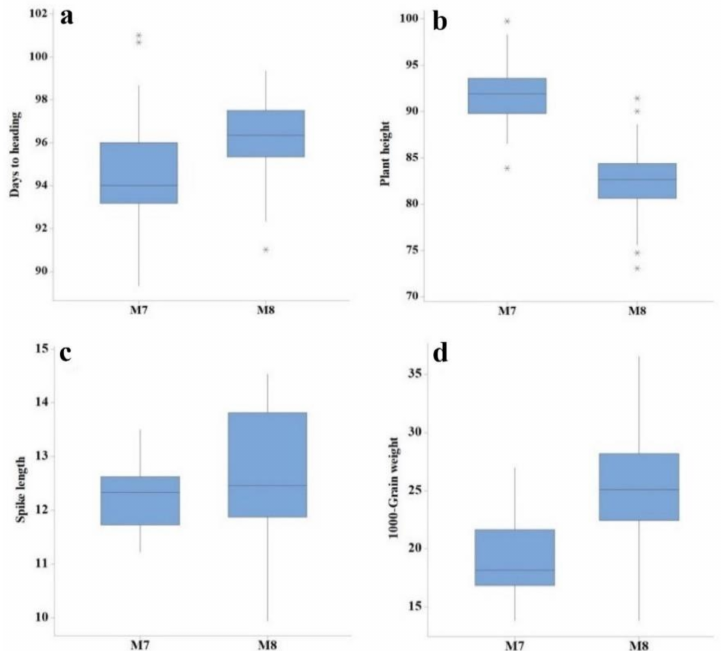
Figure 3. Boxplots showing the median, minimum, maximum, and mean values: ( a ) days to